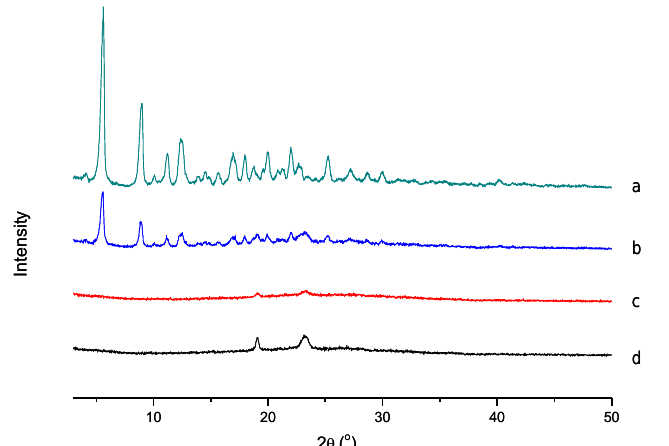
Figure 6. XRD patterns of ( a ) PTX, ( b ) physical mixture of PTX and blank micelles, ( c ) blank micelles, and ( d ) PTX-loaded micelles.